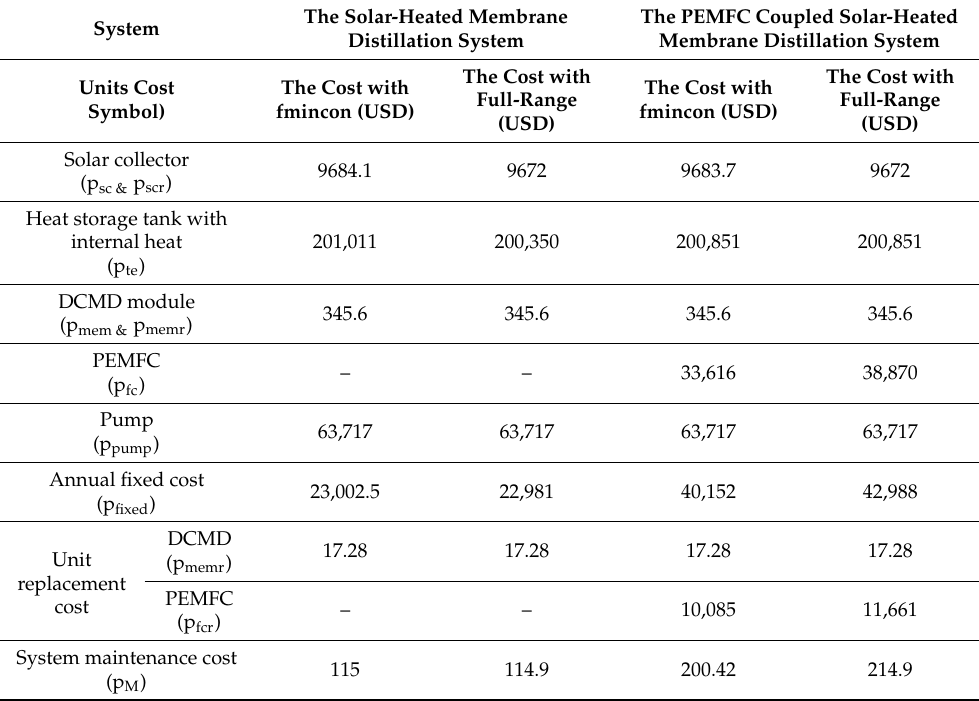
Table 10. The unit cost details of both systems with different methods.